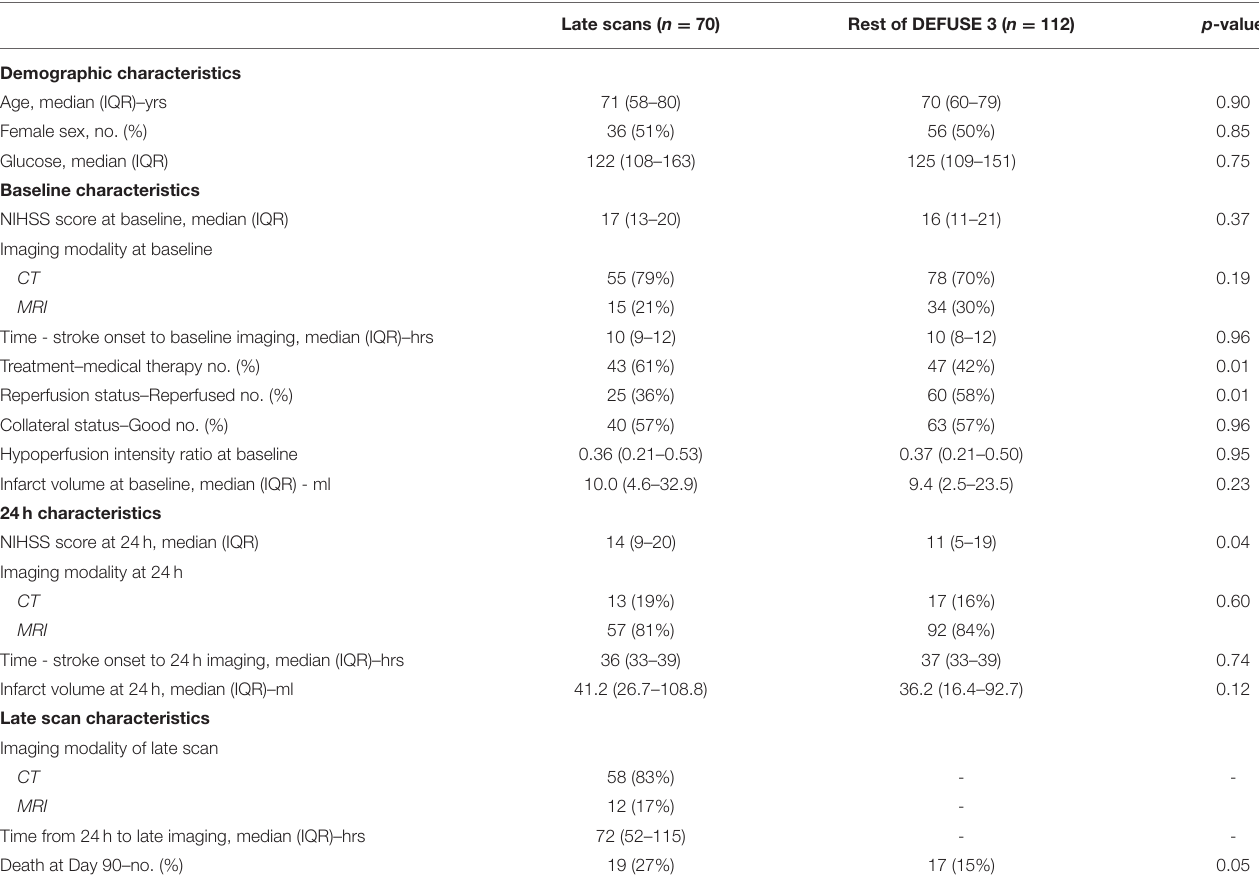
TABLE 1 | Demographic and imaging characteristics of population in this study compared to DEFUSE 3. Late scans ( n = 70) Rest of DEFUSE 3 ( n = 112) p